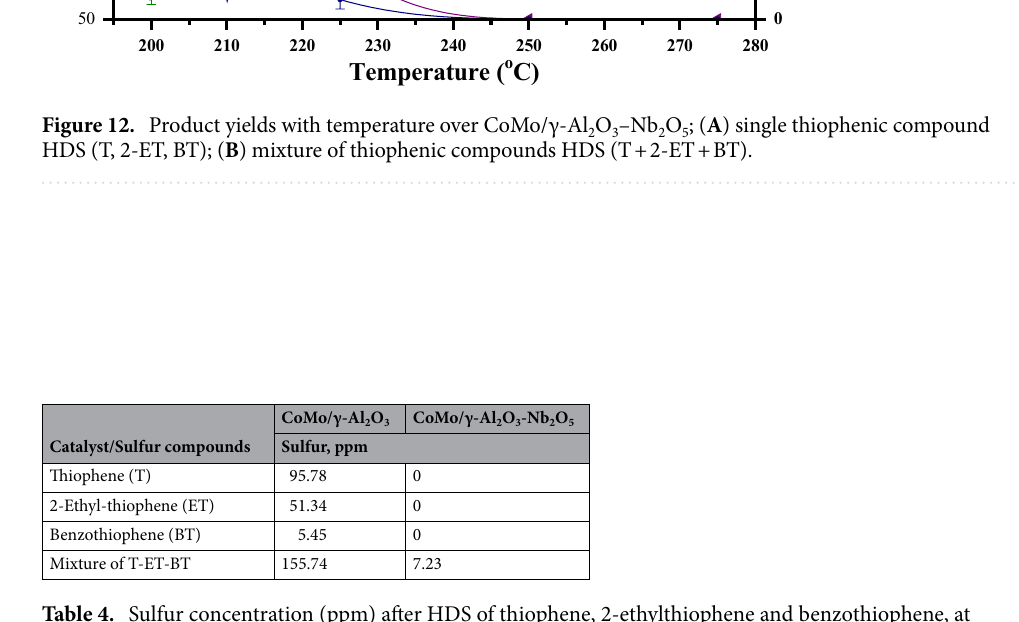
Table 4. Sulfur concentration (ppm) after HDS of thiophene, 2-ethylthiophene and benzothiophene, at 275 °C.